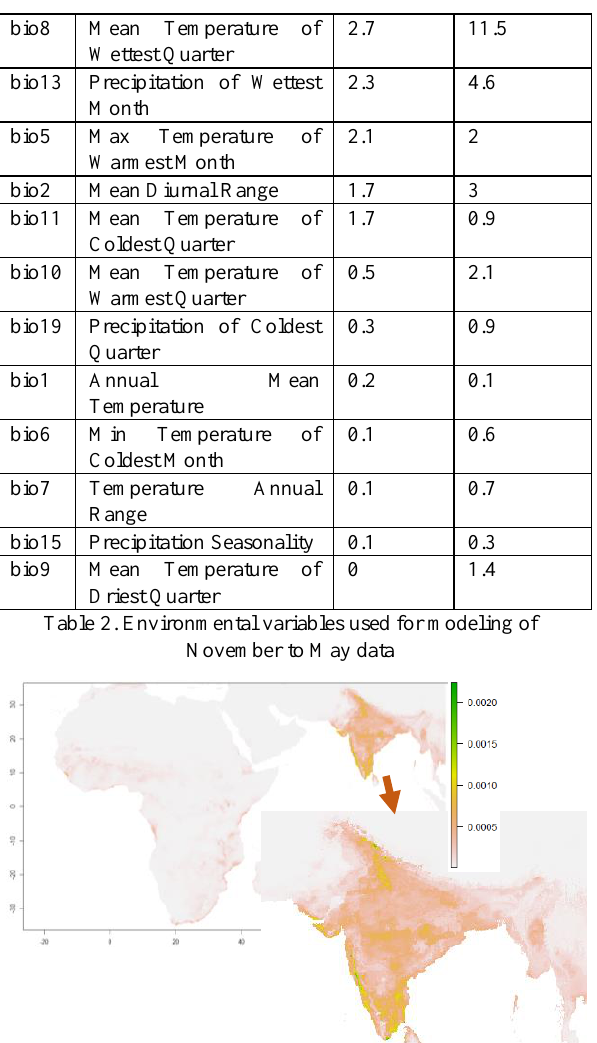
Figure 7. Current suitability of Clamator jacobinus for